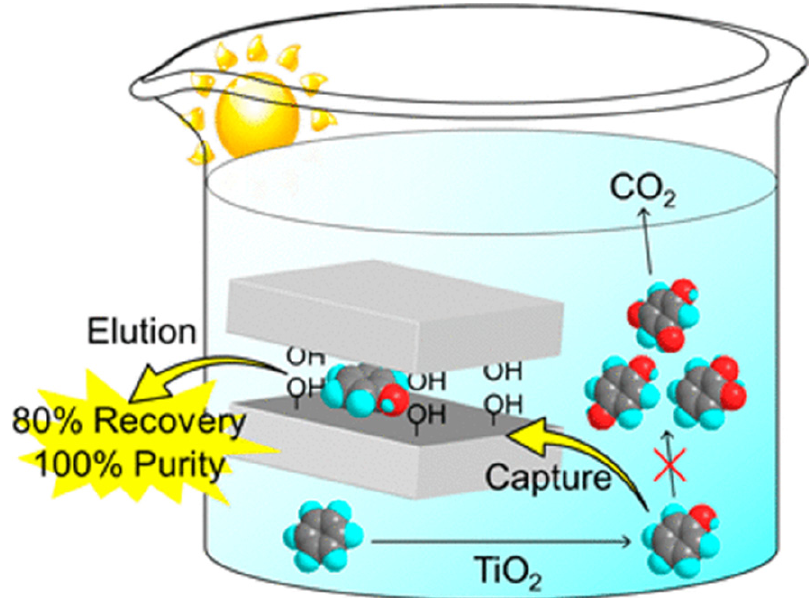
Figure 2. Schematic illustration of selective recovery of phenol by layered silicic acid in photocatalytic hydroxylation of benzene in water. Reprinted with permission from Ref. [33]. 2013 American Chemical Society.